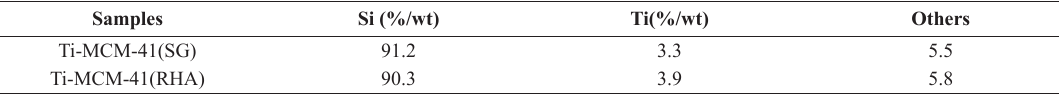
Table 2. Chemical composition of Ti-MCM-41 (SG) and Ti-MCM-41 (RHA). Samples